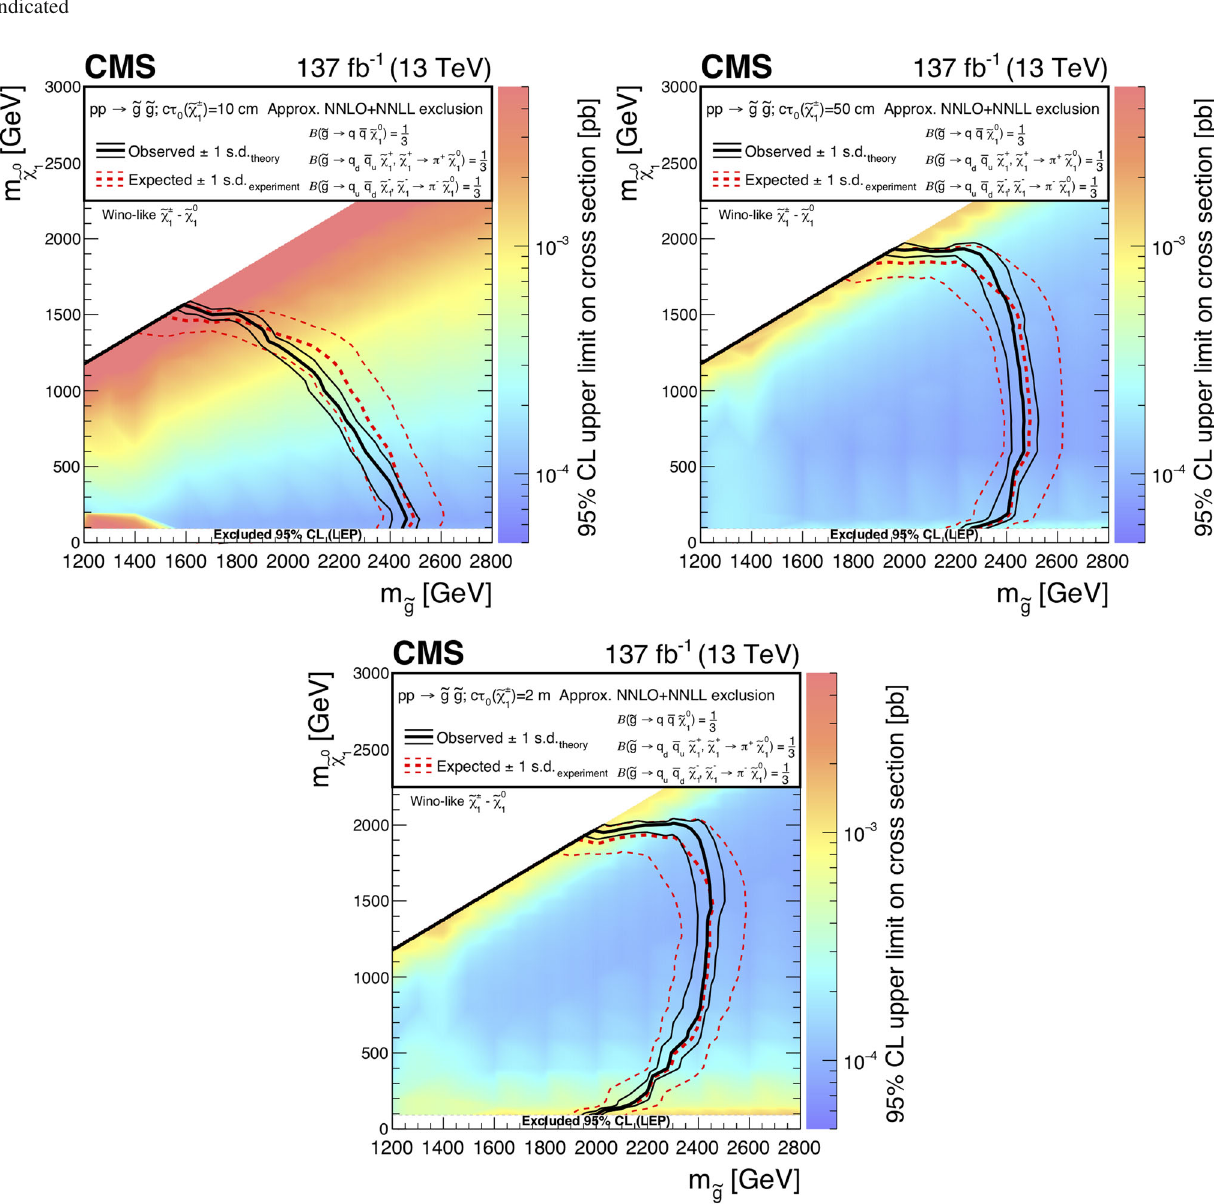
Fig. 17 Exclusion limits at 95% CL for direct gluino pair produc- tion where the gluinos decay to light-flavor (u, d, s, c) quarks, with ) = (upper left) 10cm, (upper right) 50cm, and (lower) 200cm. c τ 0 ( ˜ χ ± 1 The area enclosed by the thick black curve represents the observed exclusion region, while the dashed red lines indicate the expected lim- its and their ± 1 standard deviation (s.d.) ranges. The thin black lines